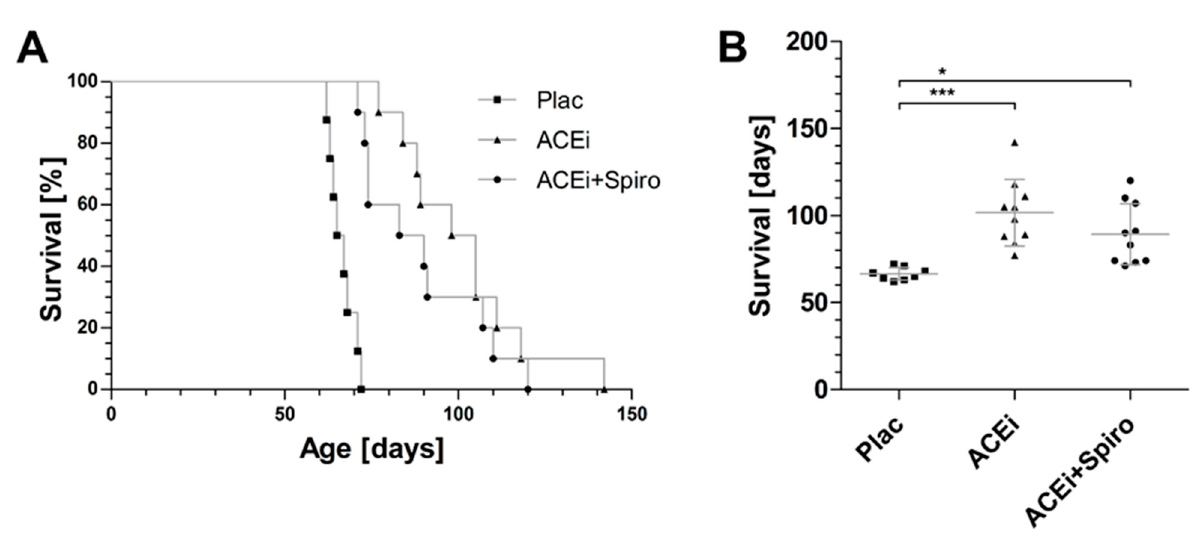
Figure 5. Therapeutic effect on timespan until end-stage renal failure. ( A ) Kaplan–Meier curves of lifespan in days until end-stage renal failure in untreated (Plac), ACEi treated and Alport mice with dual RAAS-blockade; ( B ) Box-blot of lifespan in untreated (Plac), ACEi treated and ACEi+Spiro treated Alport mice. n = 8 for Plac, n = 10 for ACEi and n = 10 for ACEi+Spiro; *** p < 0.001; * p < 0.05.